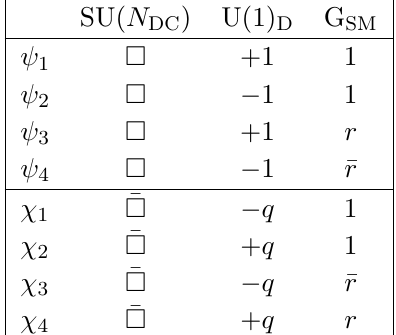
Table 2 . Minimal accidental axion models with n f = 2 . All the fields ψ i , χ i are left-handed Weyl fermions, and the parameter q is a rational number in the interval ( − 1 , 1) . The QCD and GUT models discussed in the text correspond to G and to G = SU(5) with r = 5 , SM GUT